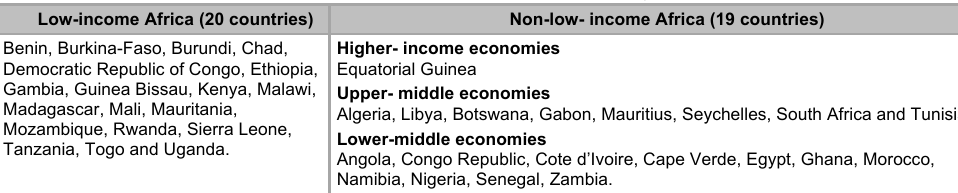
Table 1 List of countries included in the